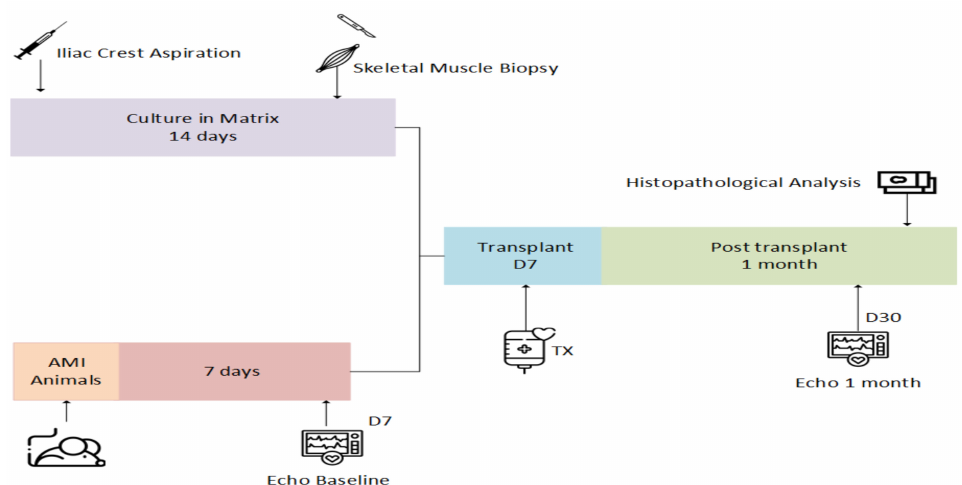
Figure 1. Experimental design: acute myocardial infarction (MI), distinct time point (D), echocardiography (Echo), and transplantation (TX).